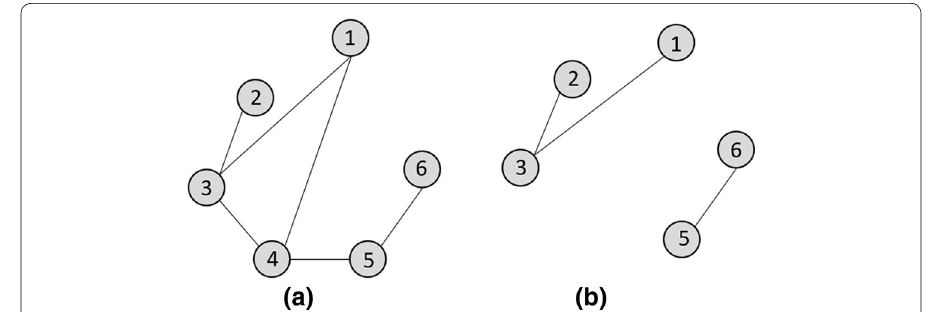
( Vr , Ed ) ; b sub-graph Gr ′ =